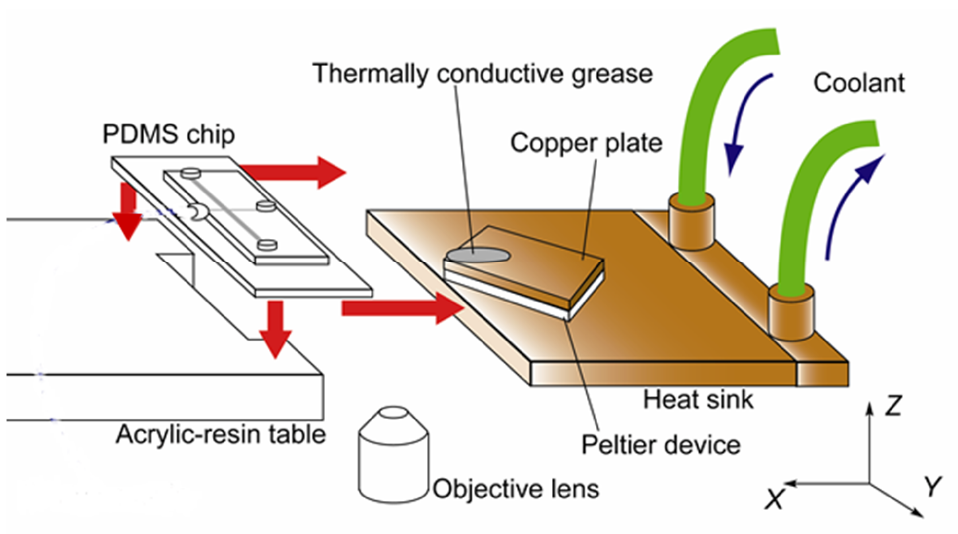
Figure 2. Arrangement of mini-channel on the bench of microscope.